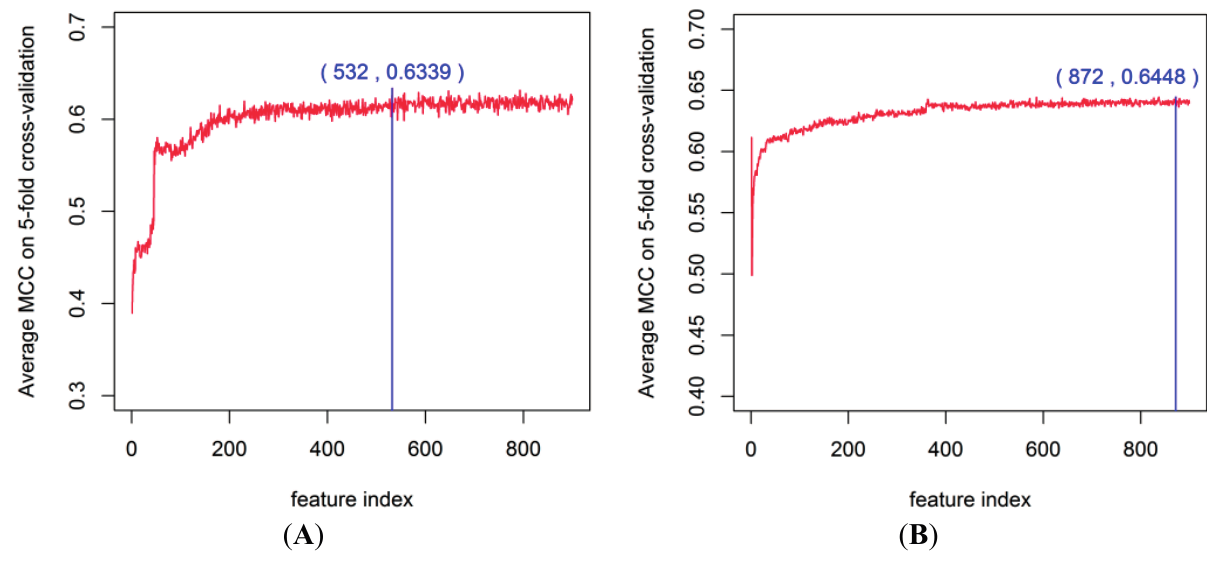
Figure 6. MCC of DXEC-RF by adding features sequentially on the Human